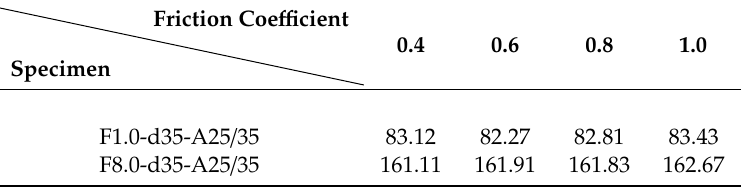
Table 3. The shear bearing capacity of test pieces under di ff erent friction coe ffi cients (unit: